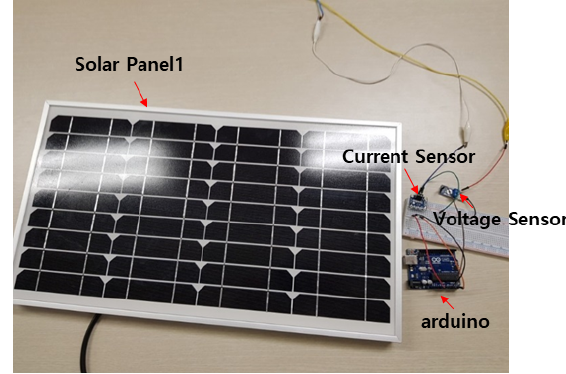
Figure 8. Circuit configuration of solar